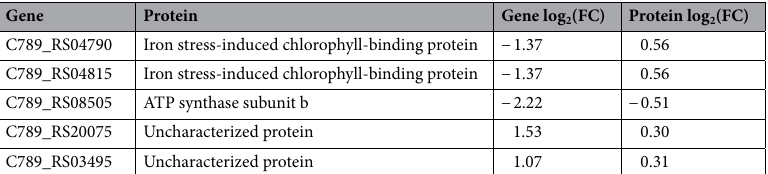
Table 3. Differentially expressed genes and proteins. Log 2 (FC) represents the logarithm of genes or protein with a fold change between E and C, with 2 as the base. Gene: If FDR < 0.05 and | log 2 FC |> 1, the difference is significant. Proteins with fold change in a comparison > 1.2, the difference is significant. All genes or proteins in this table FDR <